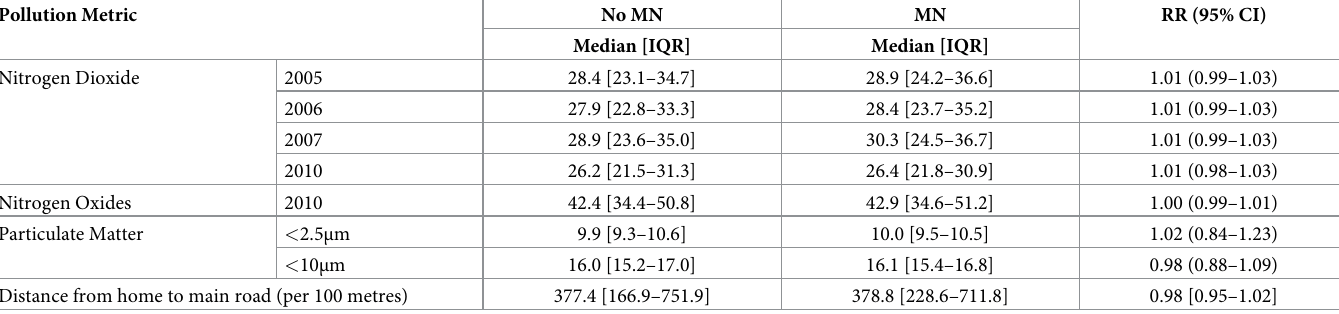
Table 6. Associations with environmental exposures presented in μ gm -3 : Pollution exposure: Identified MN cases versus controls with no diagnosed MN. Pollution